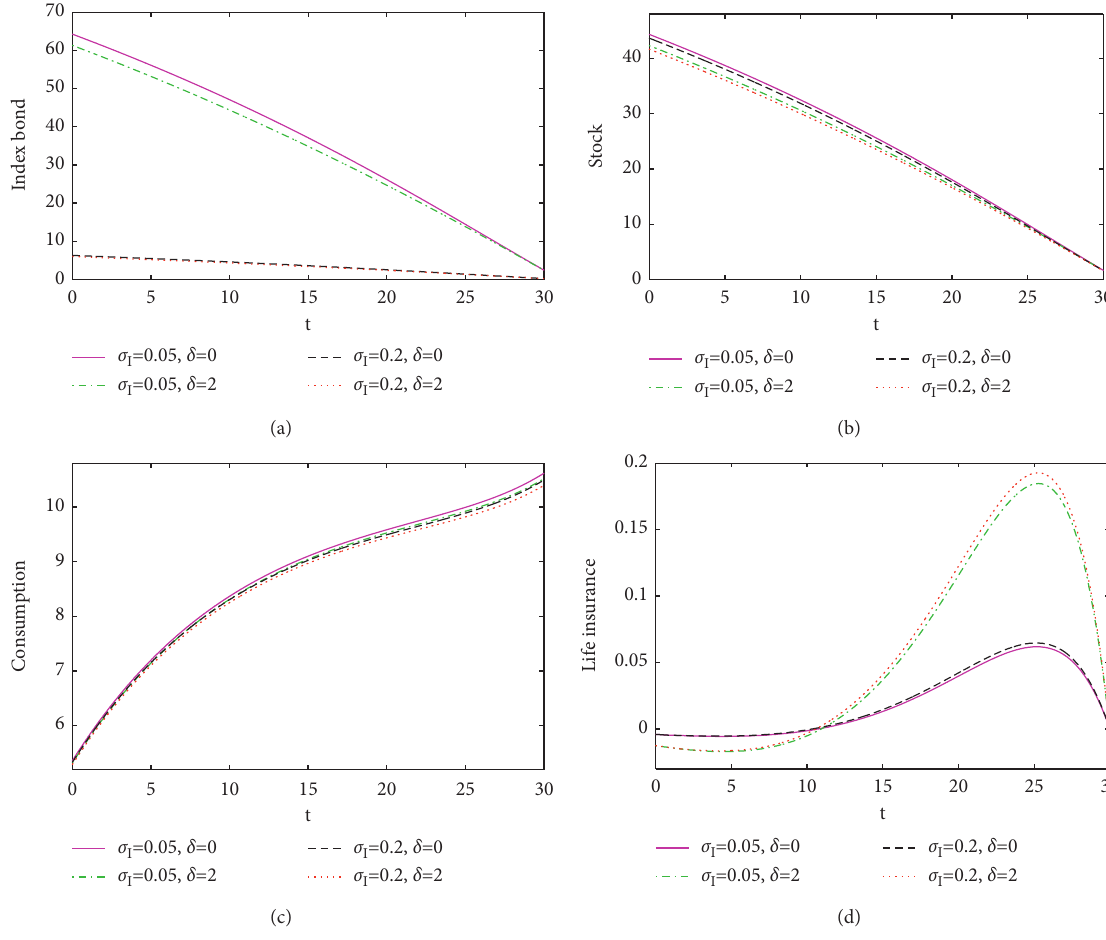
Figure 4: The effects of the inflation rate volatility and mortality force change on the optimal